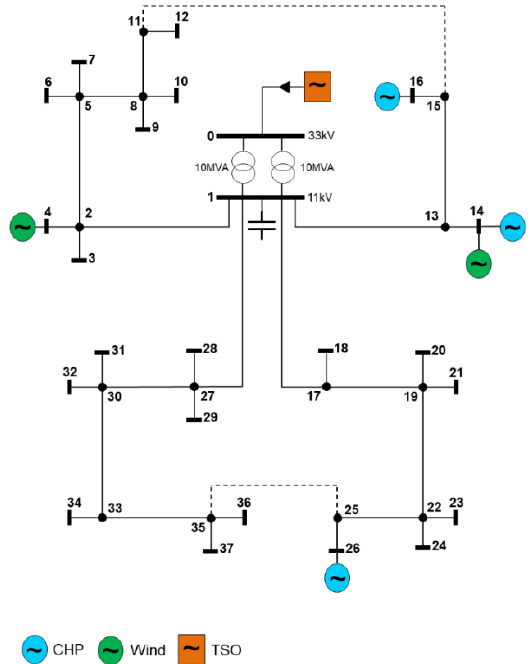
Figure 2. 37-Bus distribution network (adapted from [18]).